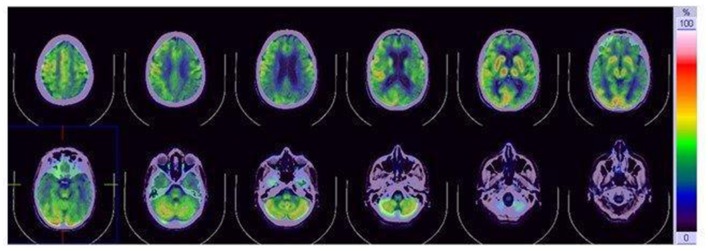
[18F]fluoro-2-deoxy-D-glucose positron emission tomography (FDG-PET). FDG-PET reduced glucose metabolism in the temporo-parietal and frontal lobe, with slight left lateralizatio. No involvement of subcortical structures is present.